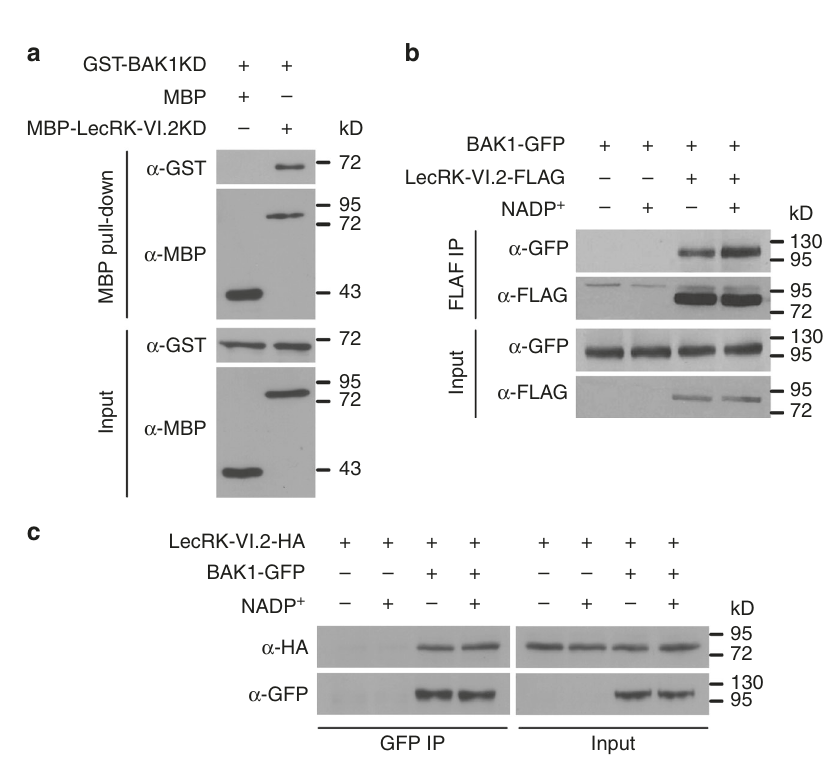
Fig. 6 Physical association between LecRK-VI.2 and BAK1. a In vitro maltose-binding protein (MBP) pull-down assay of LecRK-VI.2KD interaction with BAK1KD. Recombinant MBP or MBP-LecRK-VI.2KD was incubated with GST-BAK1KD and pulled down with amylose resin beads. Input and bead-bound proteins were analyzed by immunoblotting with monoclonal anti-MBP and anti-GST antibodies. b Co-immunoprecipitation (Co-IP) analysis of LecRK-VI.2- FLAG association with BAK1-GFP in N. benthamiana . Total proteins (input) of N. benthamiana leaves transiently co-expressing LecRK-VI.2-FLAG and BAK1- GFP, or transiently expressing BAK1-GFP alone, were immunoprecipitated with anti-FLAG af fi nity agarose beads and the precipitates were analyzed